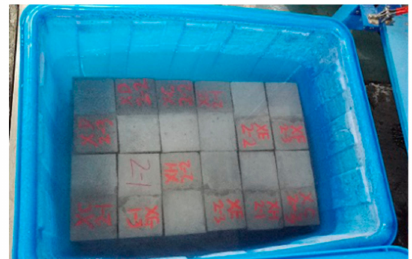
Figure 15. The concrete combinations were soaked for 4 days.